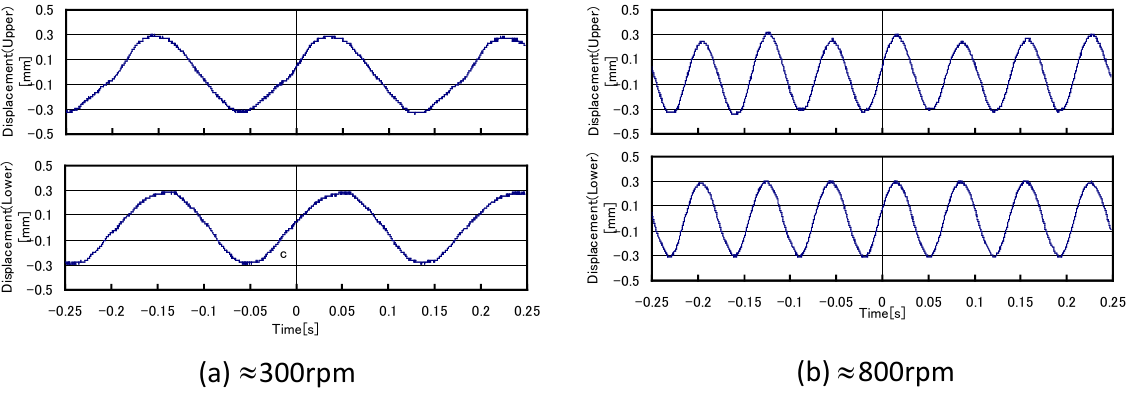
Figure 7. Free-run experimental results representing ( a ) displacements at the upper rotor (upper figure) and lower rotor (lower figure) at a speed of ≈ 300 rpm and ( b ) displacements at the upper rotor (upper figure) and lower rotor (lower figure) at a speed of ≈ 800 rpm. Figure 8 shows the free-run experimental results representing (a) a natural rotation decay curve, (b) displacement at the center position of the rotor and (c) displacement of the stator in just the upper position of the rotor. The rotation speed decays to zero from ≈ 1000 rpm for 1600 s. During the rotation, the displacement at the center position of the rotor is almost the same as those in Figure 6a,b. Since the flywheel rotor has a cylin- drical motion, the displacement at the center position of the rotor in Figure 8b is almost